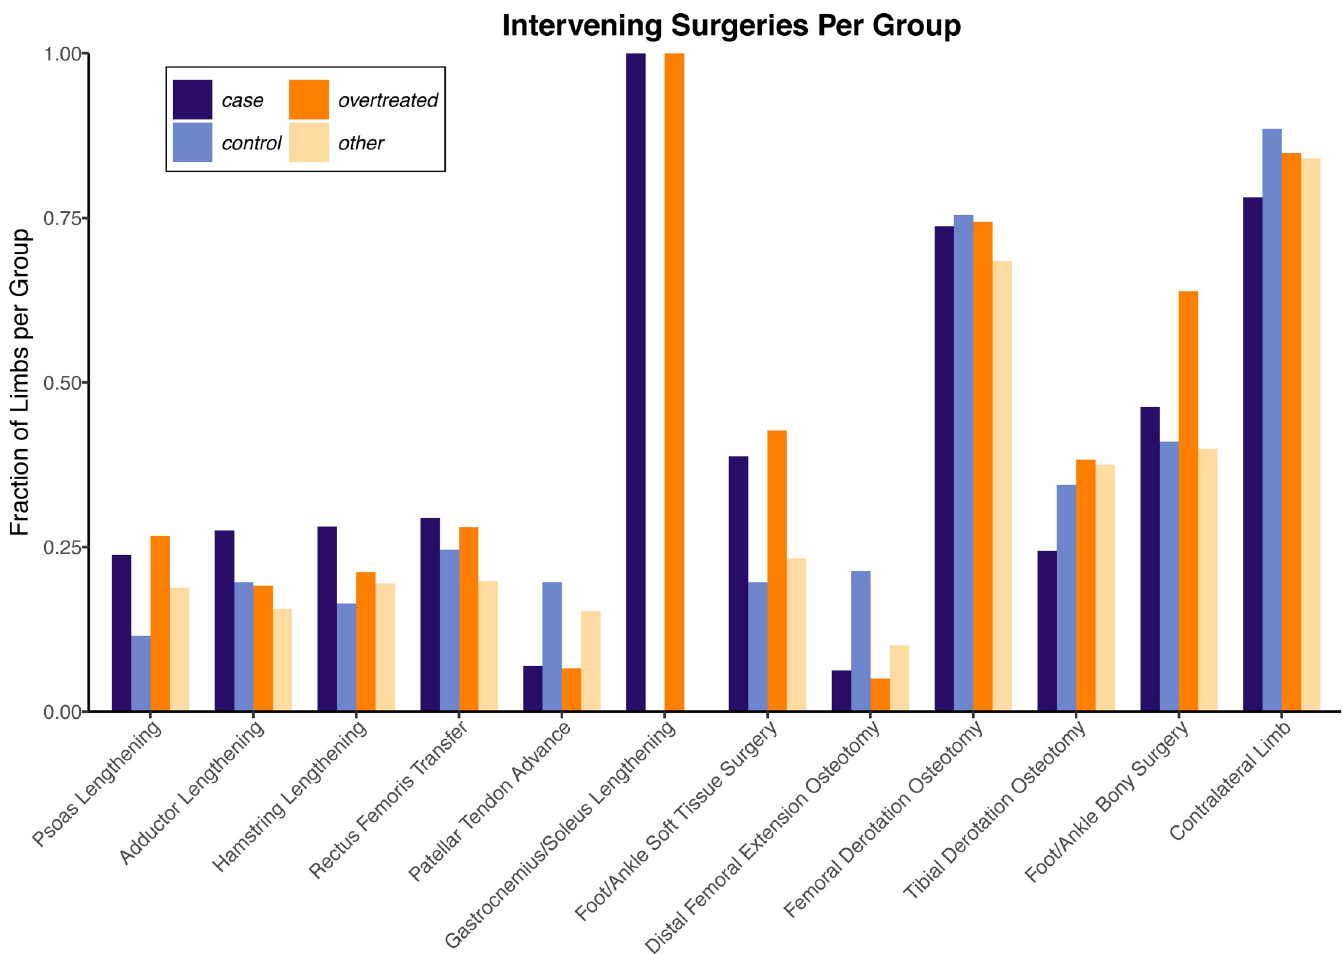
Fig 1. Intervening surgeries between analyzed gait visits. For the short-term analysis, each limb underwent at least two of the orthopedic procedures tabulated above (not including the “Contralateral Limb” count). Limb cohorts generally had similar intervening surgeries, though the case and overtreated limbs tended to have more concurrent surgical procedures at the foot and ankle level than the control and other